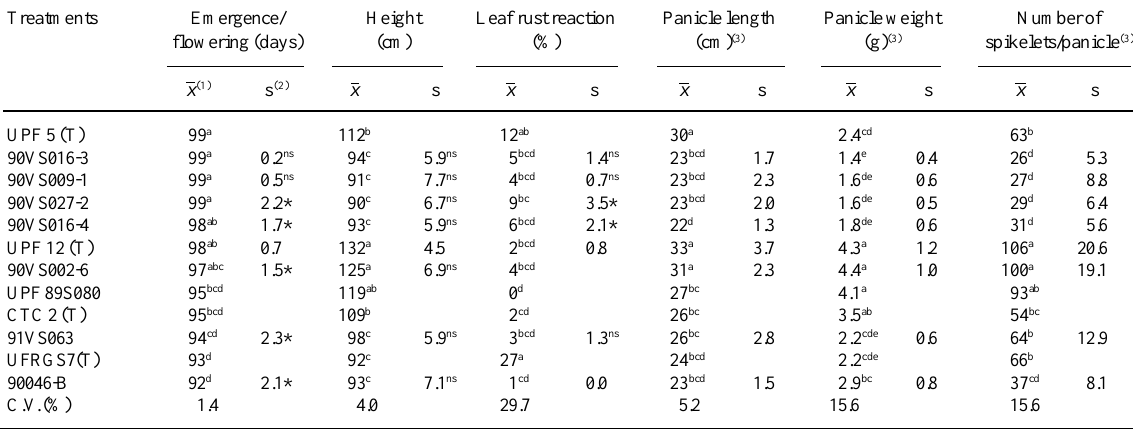
Table IV - Comparison between means and standard deviations from oat somaclones derived from cultivar UPF 12 and controls. Evaluated traits were: days between emergence and flowering, plant height, leaf rust reaction, panicle length and weight and number of spikelets per panicle. Experiment 3. EEA/UFRGS, Eldorado do Sul, RS, 1994.